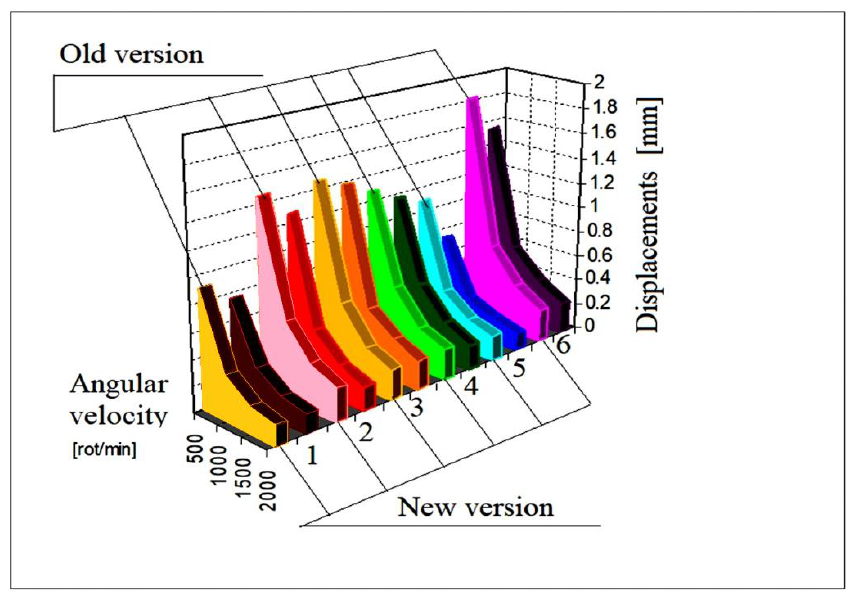
Figure 40. Synthesis of displacements measured on the housings of the two adder gearboxes. 4.